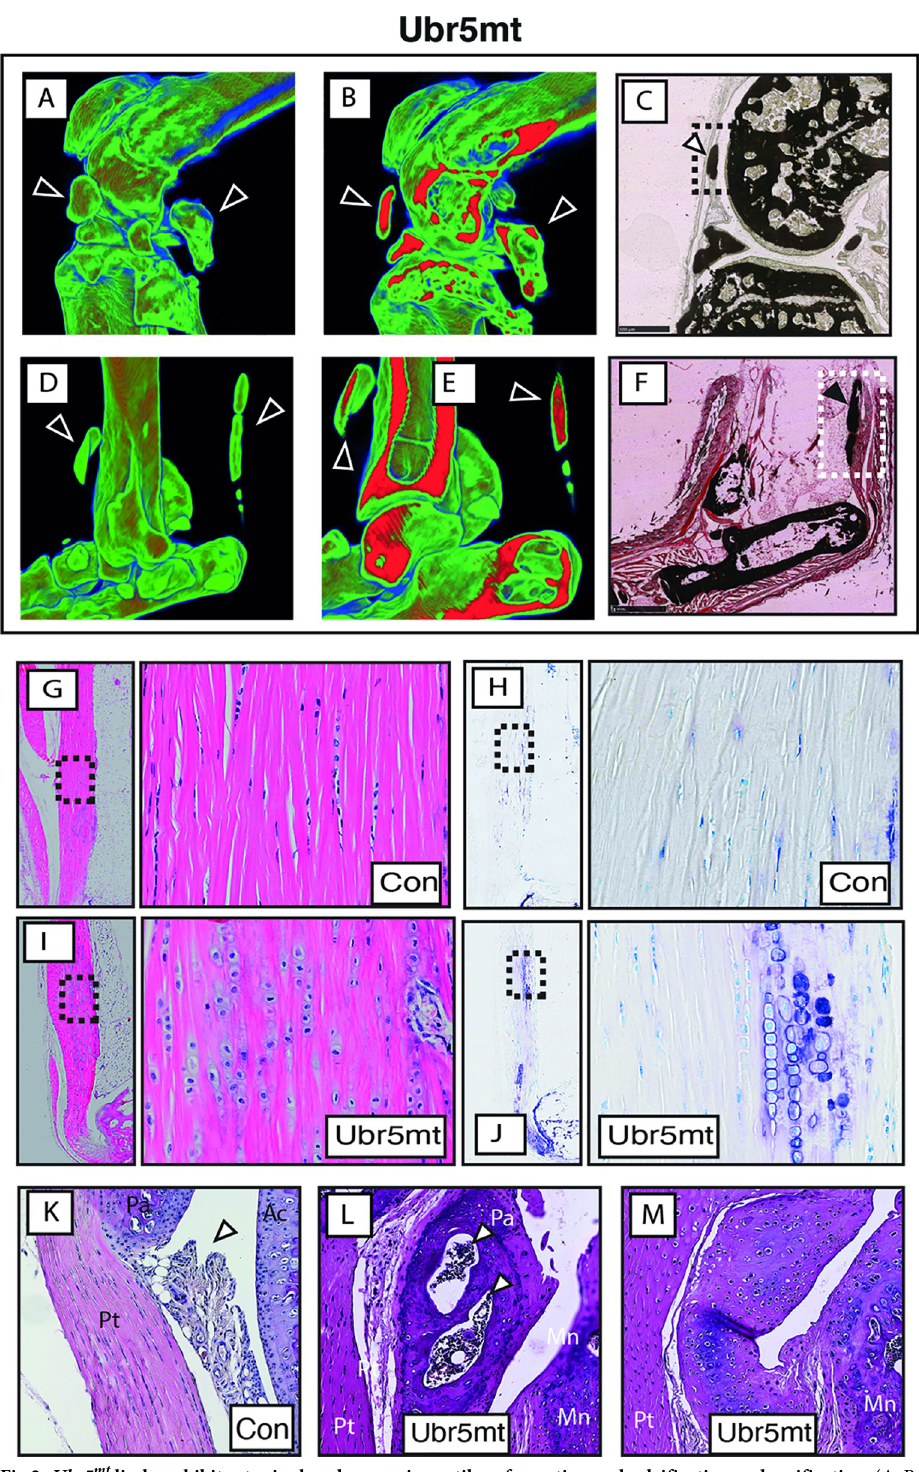
Fig 2. Ubr5 mt limbs exhibit ectopic chondrogenesis, cartilage formation and calcification and ossification. (A, B, D, E) Colour-coded X-ray density maps of volume rendered Ubr5 mt knee (A B) and ankle (D, E) joints. (B, E) show cross-sections through the joint to reveal the internal structure and density. Arrowheads indicate ectopic structures indicated in Fig 1F and 1H. Low density = blue and High density = red. Sagittal sections (C, F) from 20-week-old or 24-week-old animals are shown. (C, F) Von Kossa staining of Ubr5 mt knee (C) and ankle joints (F). (C) Ubr5 mt